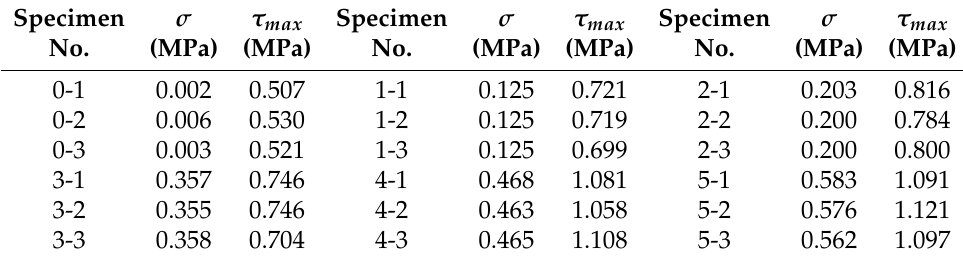
Figure 10. Time dependency of the shear stress at six normal stress levels. Table 5. The maximum shear stress of various specimens at different normal stress